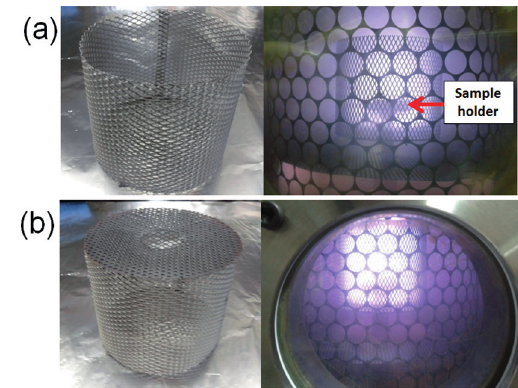
Figure 1: Different cathodes configuration: (a) Active Screen Partial System, (b) Active Screen System